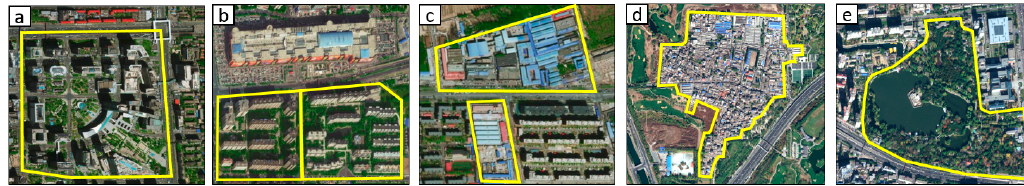
Figure 1. A comparison of different urban functional zones outlined by yellow polygons: ( a ) a commercial zone; ( b ) residential districts; ( c ) industrial zones; ( d ) a shanty town; and ( e ) a park.